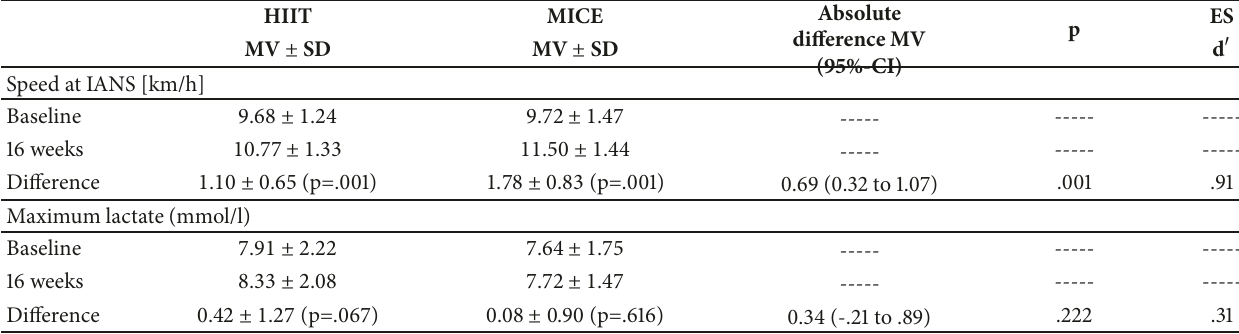
Table 4: Results for the secondary endpoints “velocity at anaerobic threshold” and “maximum lactate”. Mean values, standard deviations, and mean difference between the groups with 95% confidence interval, as well as significance values of the intergroup comparison and corresponding effect size (ES). Numerical value in parentheses: significance value of the change within the groups between base and final (16-week